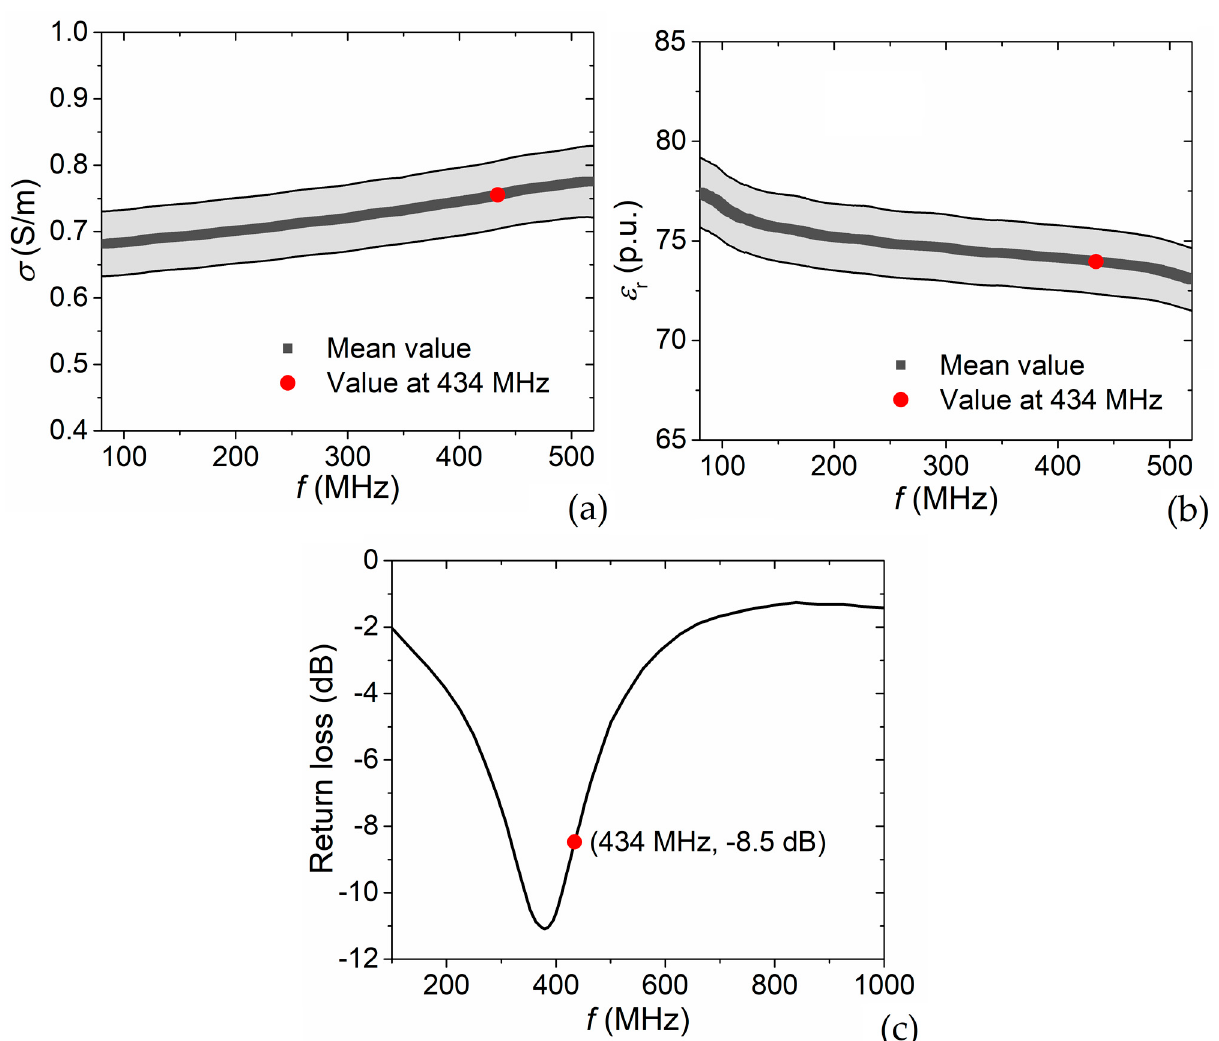
Figure 4. Frequencies dependencies of phantom ( a ) electrical conductivity and ( b ) relative permittivity, measured with a coaxial probe (mean values and standard deviations are reported). ( c ) Frequency dependence of the return loss of the RF applicator, measured under operation conditions (phantom within the aperture).